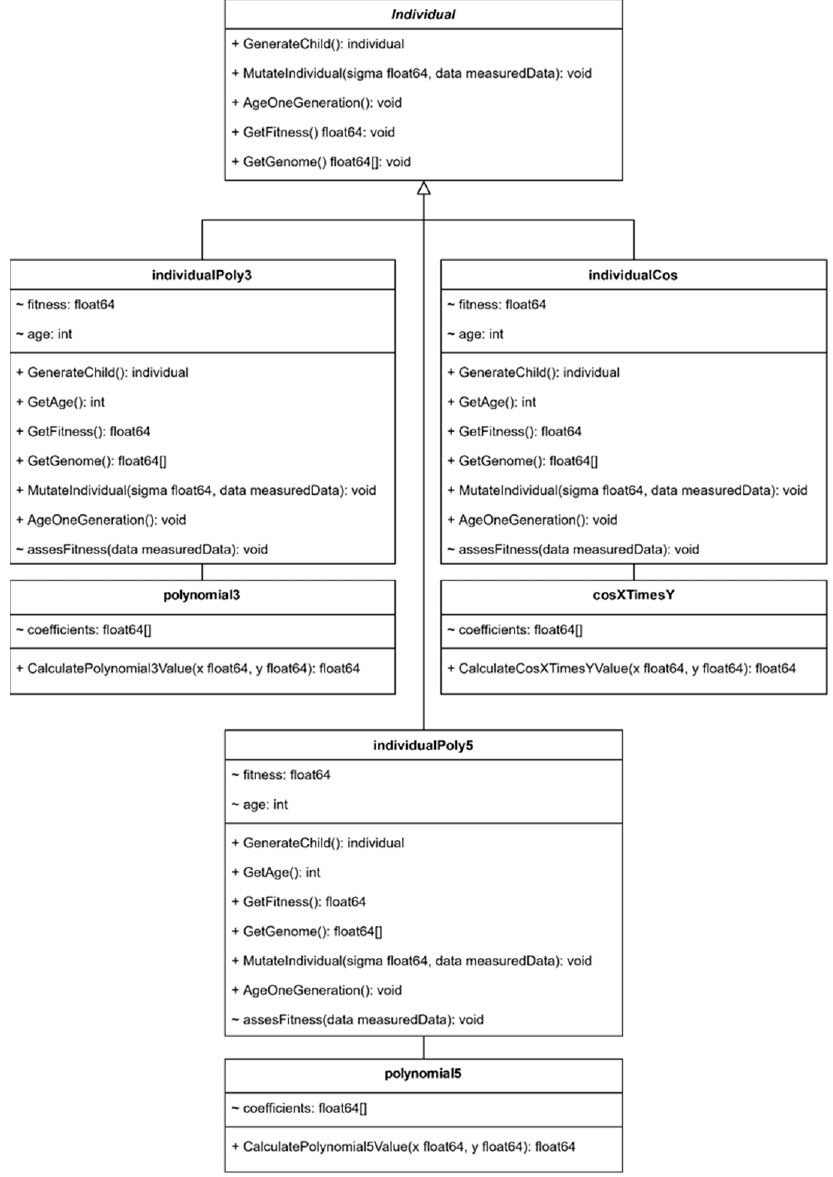
Figure 8. Diagram of implemented classes (1).